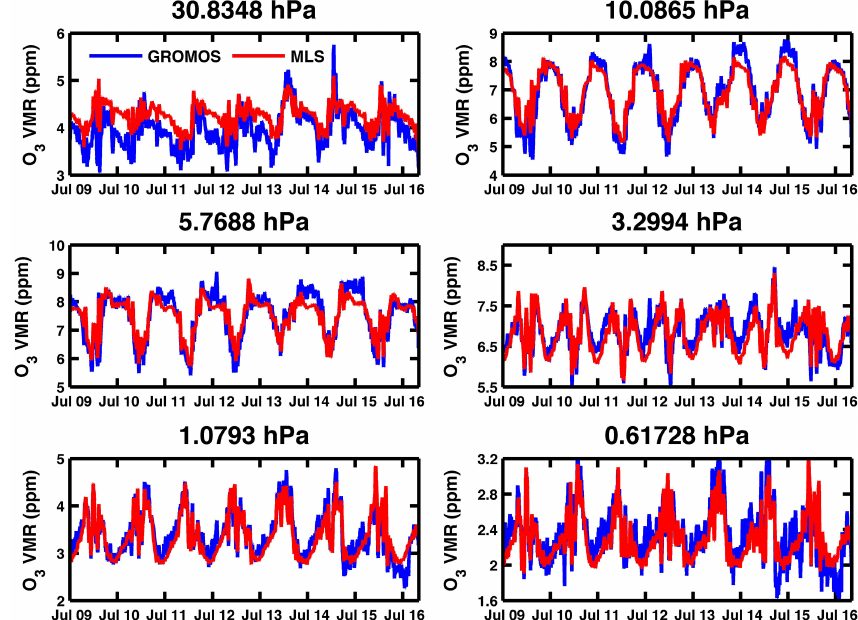
Figure 4. Time series of averaged daytime and nighttime O 3 VMR measurements of GROMOS (blue line) and MLS (red line) for the period from July 2009 to November 2016 at different pressure levels. An averaging kernel smoothing has been applied to the series of the MLS measurements coincident in time and space with the GROMOS measurements. Both time series are smoothed over seven points or ∼ 1 week in time by a moving average.